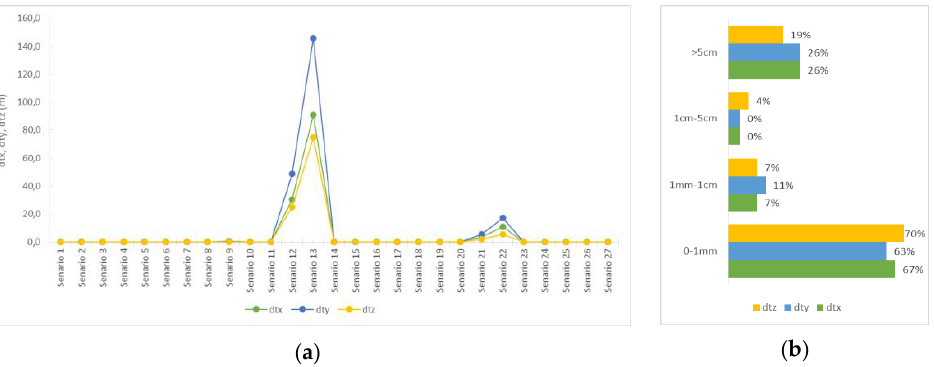
Figure 5. ( a ) Deviations in meters for translation per axis in quaternion method. ( b ) Histogram of deviations for translation per axis in the quaternion method